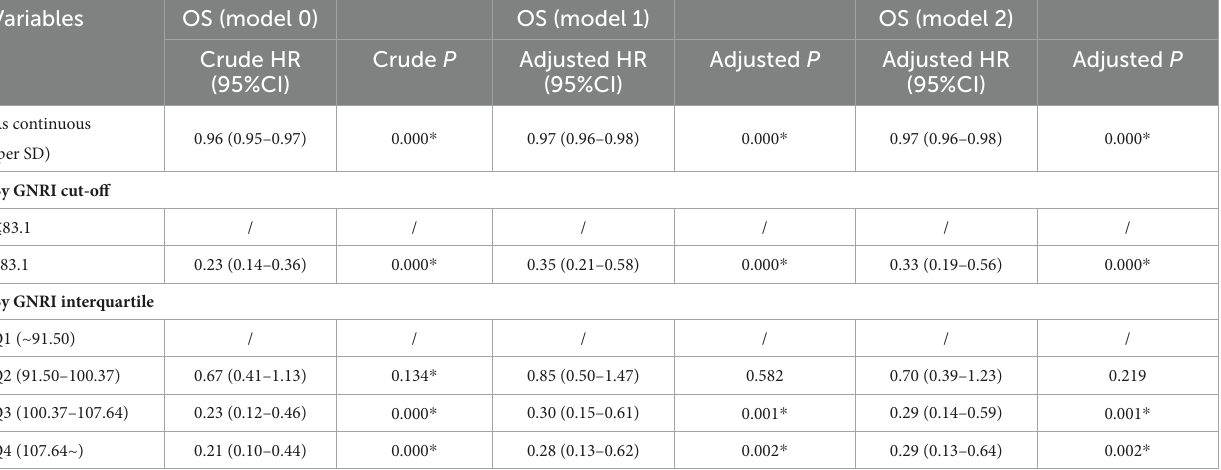
TABLE 3 Univariate and multivariate analysis on the OS of GNRI.